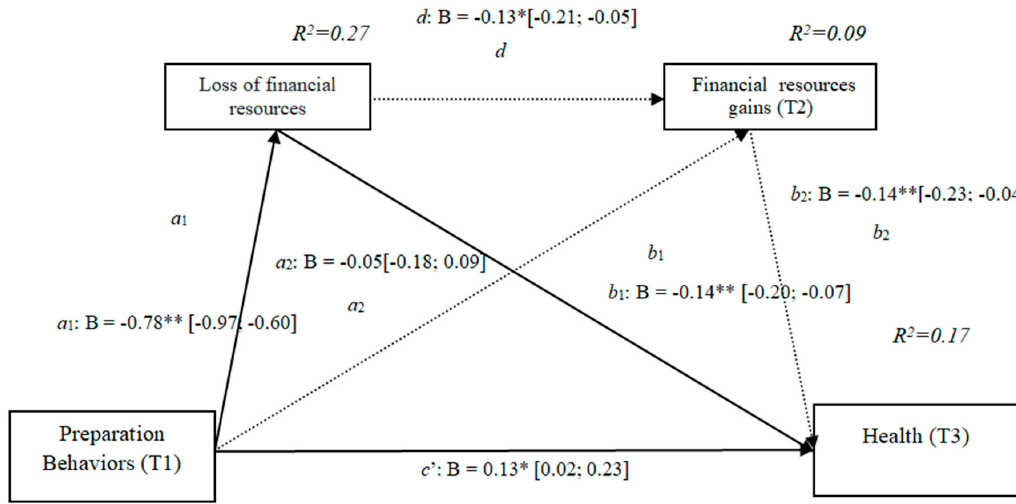
Figure 11. Non-standardized B coefficients, confidence intervals, and statistical significance for financial losses and gains. [95% CI]; * p < 0.05; ** p < 0.01.